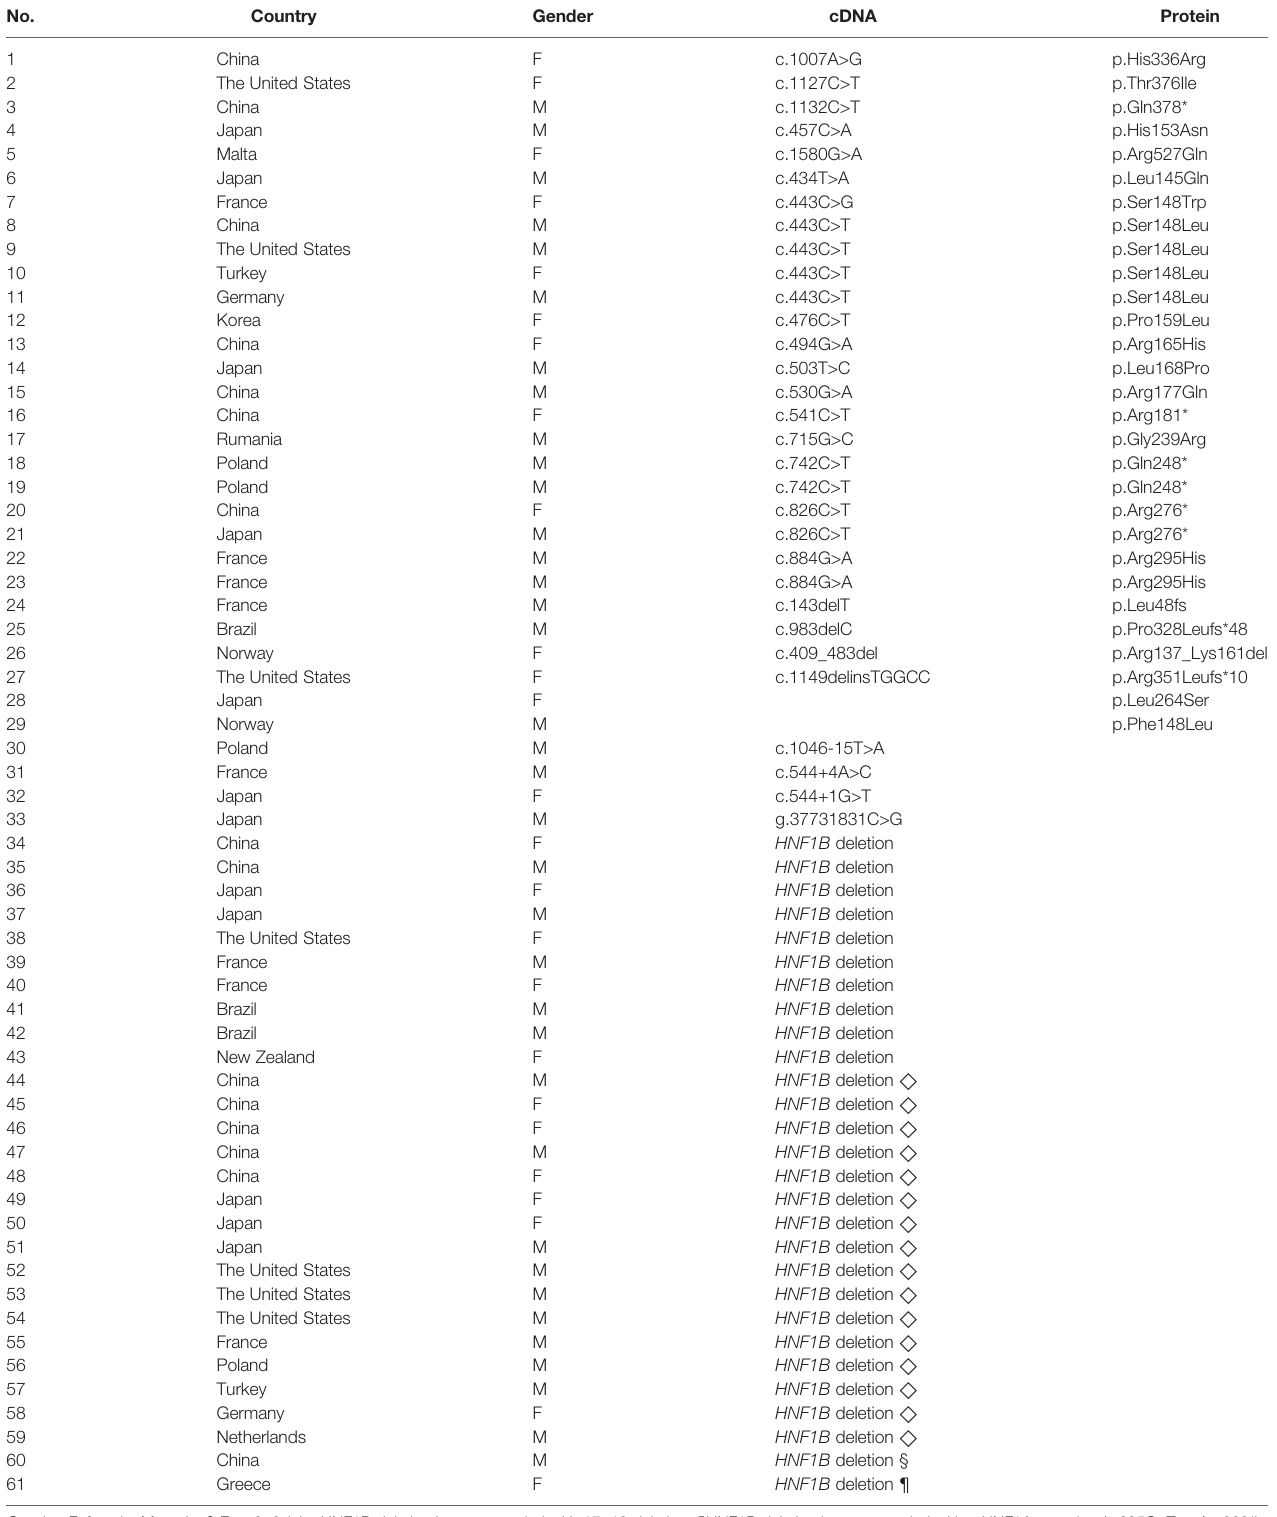
TABLE 2 | HNF1B mutations of MODY5 patients.